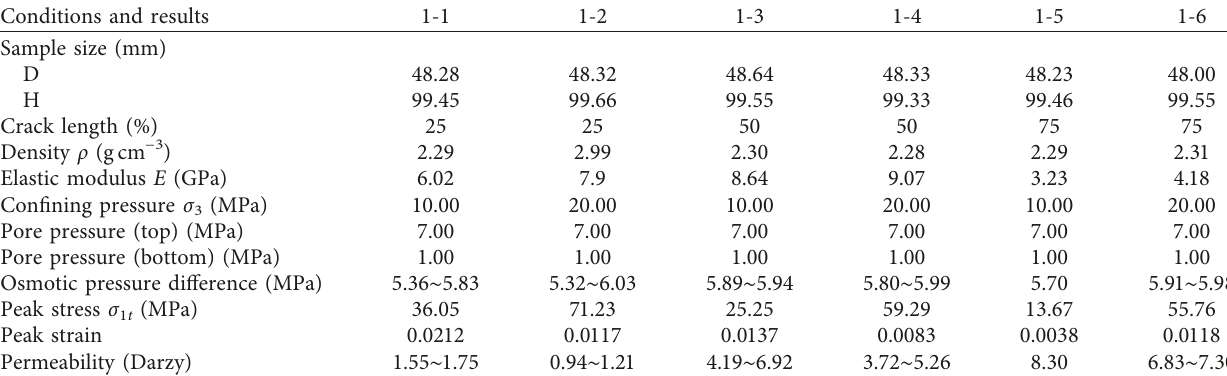
Table 1: Seepage test results of cracked sandstone filled with gypsum mortar.